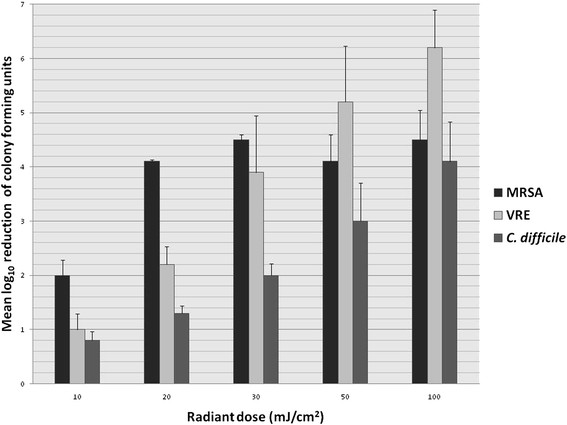
Mean reduction (log10colony-forming units (CFU)/cm2in recovery of multiple strains ofClostridium difficilespores, methicillin-resistantStaphylococcus aureus(MRSA), and vancomycin-resistantEnterococcus(VRE) suspended in phosphate-buffered saline. The Sterilray far-ultraviolet irradiation device was operated at radiant doses ranging from 10 to 100 mJ/cm2 for ~5 seconds.